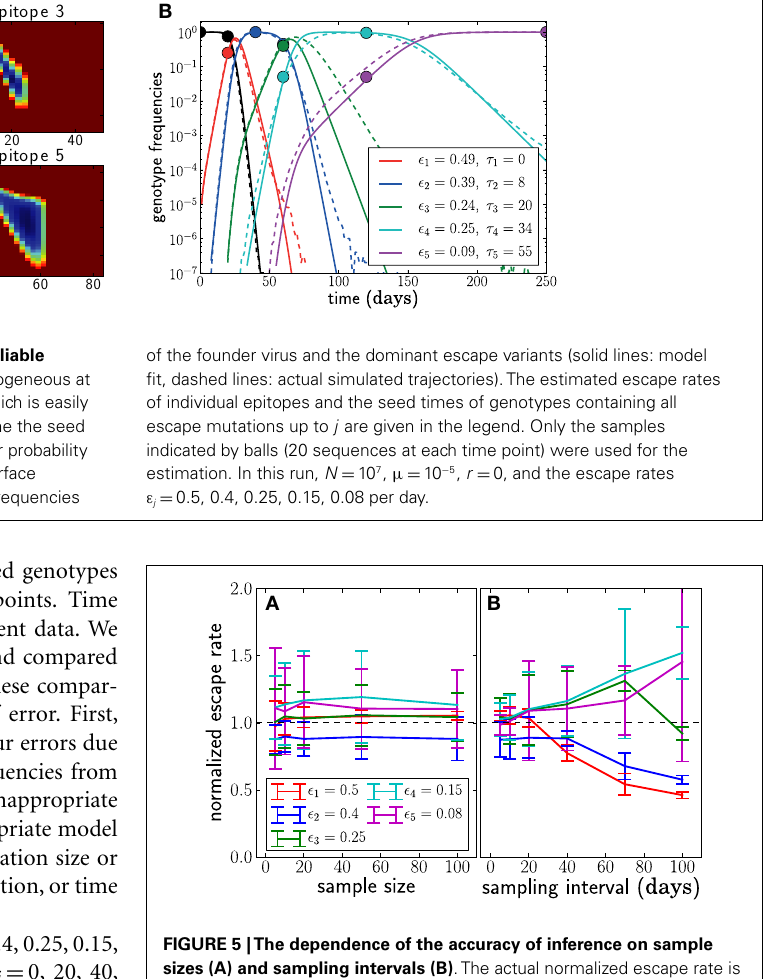
FIGURE 5 |The dependence of the accuracy of inference on sample sizes (A) and sampling intervals (B) .The actual normalized escape rate is 1.0 and is shown by the dashed line. Sample size only moderately affects the accuracy, while sparse sampling (every 40days in this example) leads to serious loss of accuracy. Sample size is n = 20 when sample intervals are varied, and sampling times are as illustrated in Figure 2 when sample size is varied.The plots show the mean ± one standard deviation.The actual values of the escape rates simulated are shown in the legend (same on both panels). In each run, N = 10 7 , µ = 10 − 5 , and r = 0. Mean and standard deviation at each point are calculated from 100 independent